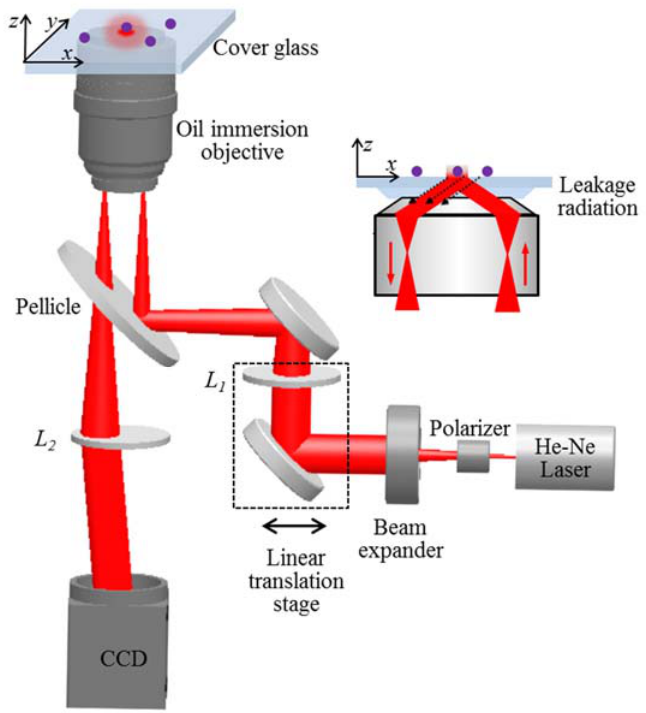
Figure 2. The experimental setup for the total internal reflection (TIR)-based leakage radiation microscopy. The inset shows the mechanism of the TIR-based leakage radiation.